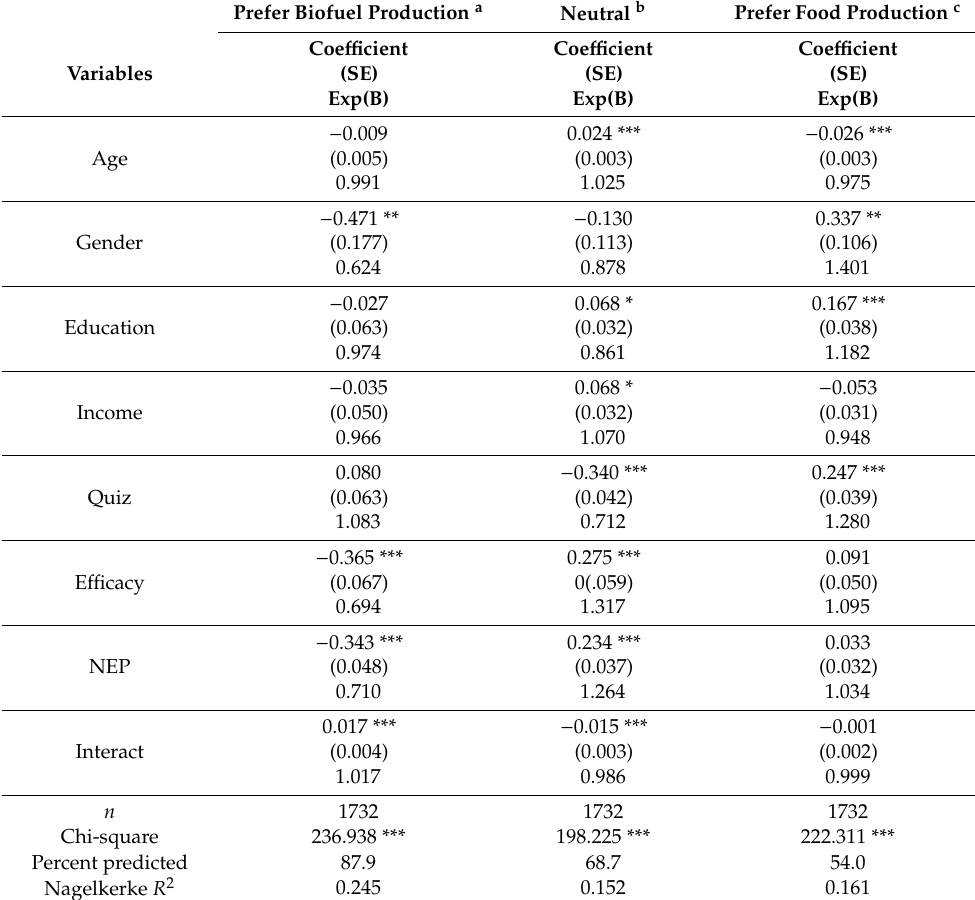
Table 4. Logistic regression estimates for the energy–food production tradeo ff